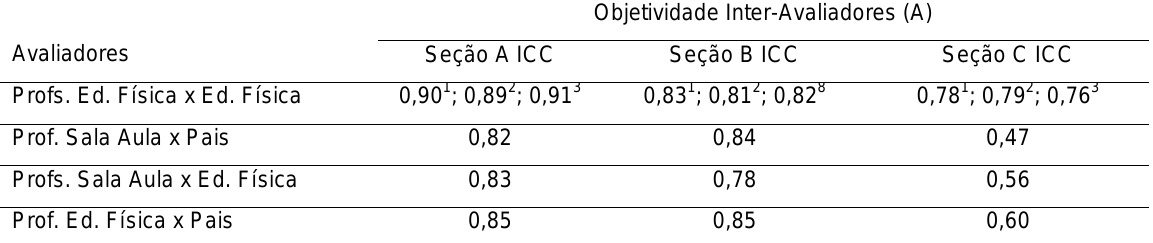
Tabela 4. Objetividade